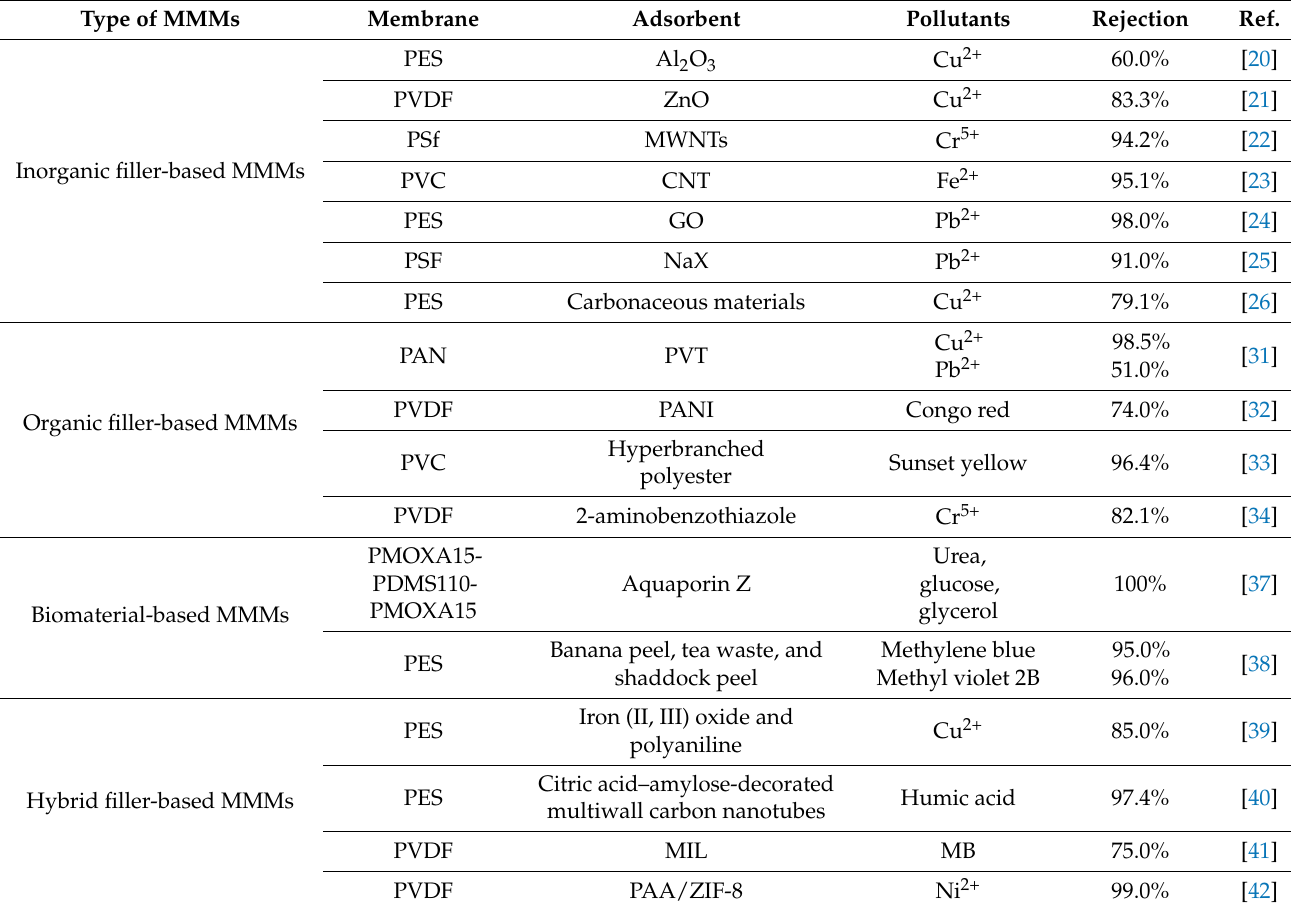
Table 1. Summary for fabrication